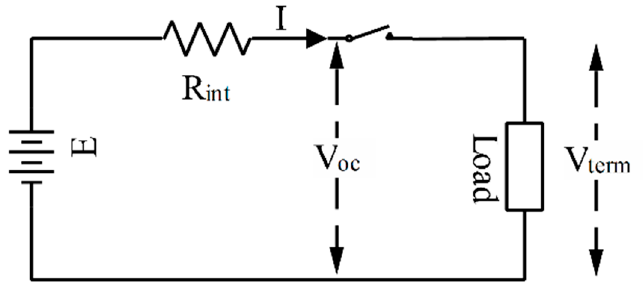
Figure 2. Simple internal resistance model of a battery.